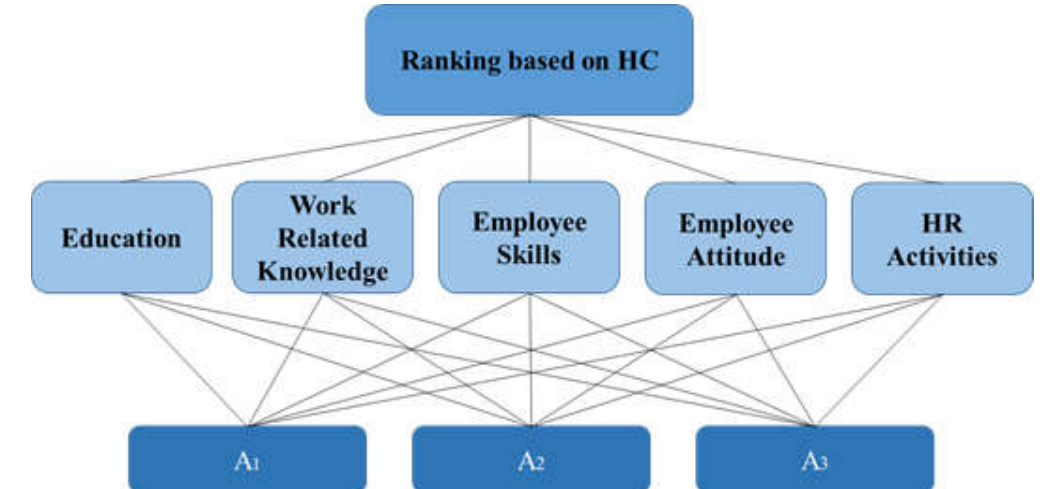
Fig. 1: The conceptual framework consists of goal, criteria and alternatives